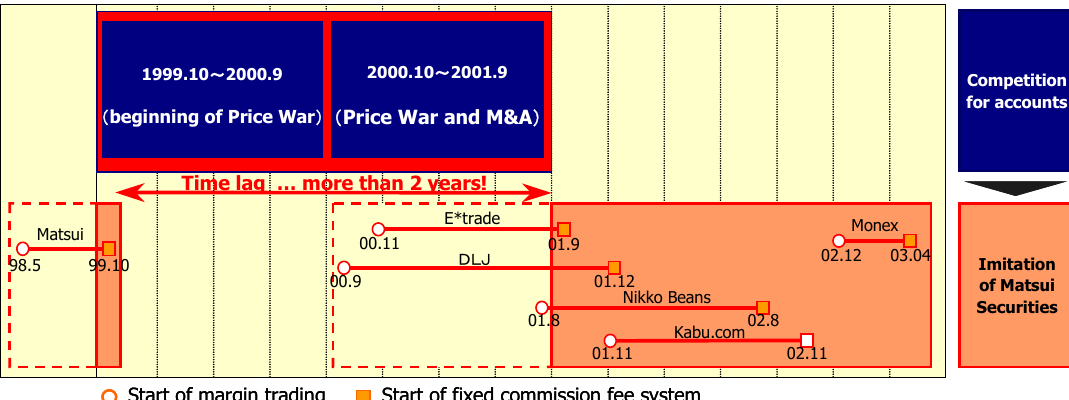
Start of fixed commission fee